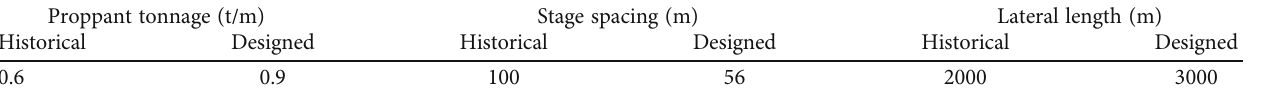
Table 2: Completion parameter comparison between designed and